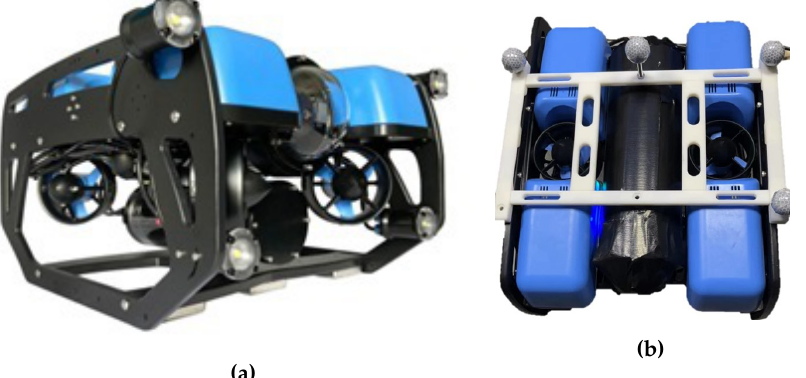
Figure 17. ( a ) BlueROV2 from Blue Robotivs, Inc.; ( b ) ROV with four reflective markers of 30